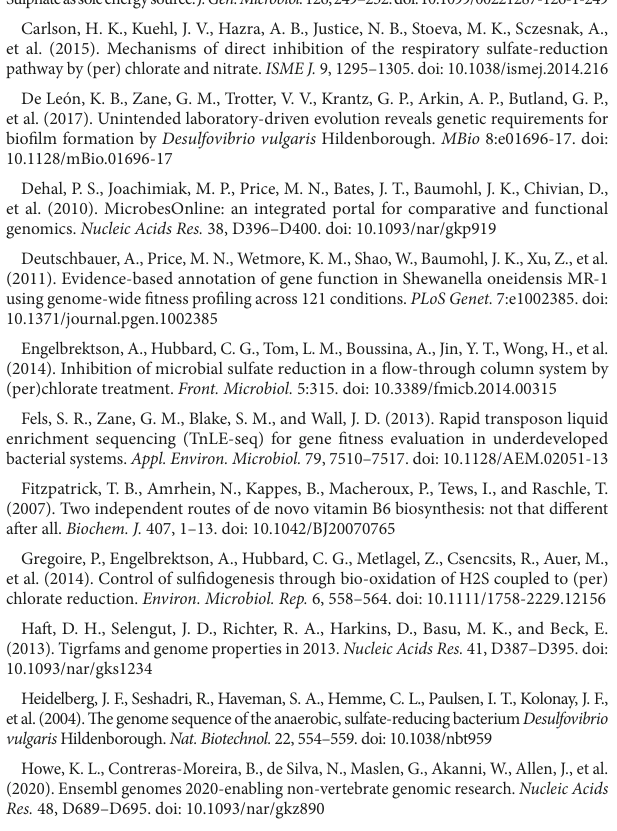
SUPPLEMENTARY FIGURE S1 Genes of the de novo UMP biosynthesis pathway are marked in green, all of these genes are essential for viability in the JW710 background that contains a deletion of upp. In contrast, all 8 of these genes are non-essential in the wild-type DvH background, as the intact upp provides a route to synthesize UMP. SUPPLEMENTARY FIGURE S2 Insertion coverage of mapped transposon insertions in the DvH JW710 RB-TnSeq mutant library across the chromosome (A) and megaplasmid (B) . SUPPLEMENTARY FIGURE S3 Biotin cluster genes conservation in the Desulfobacterota and Chrysiogenetes. The birA genes are shown only when located in the direct vicinity of a bio gene. In Halodesulfovibrio spirochaetisodalis genome, the gene homolog to DvH DORF41491 was added to the original annotation. The regions of Desulfobacterium vacuolatum DSM 3385 genome shown in the figure represent the end and beginning of two separate contigs. SUPPLEMENTARY FIGURE S4 Growth of DvH in lactate-sulfate minimal medium with different compounds as the sole source of nitrogen: N2(90%atm), NH4, valine, leucine, isoleucine and glutamate (20mM). Measurements were made in a Bioscreen growth analysis system and each curve is the average of four